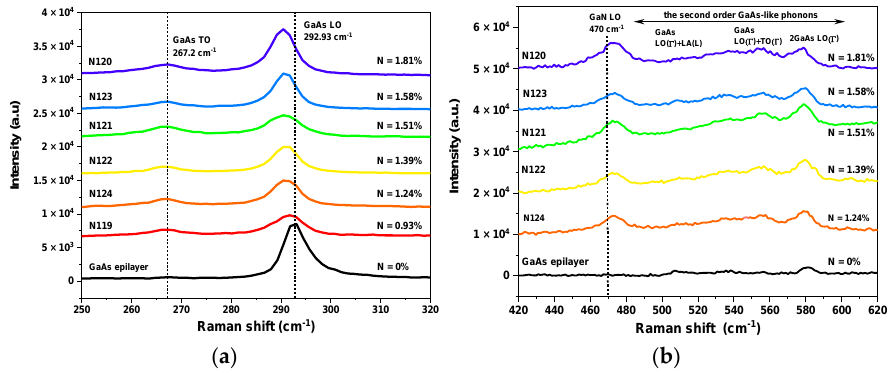
Figure 4. The Raman spectra of the investigated GaAsN/GaAs heterostructures recorded in the spectral range of: ( a ) the first order GaAs-like modes; ( b ) the first order GaN-like and the second order GaAs-like